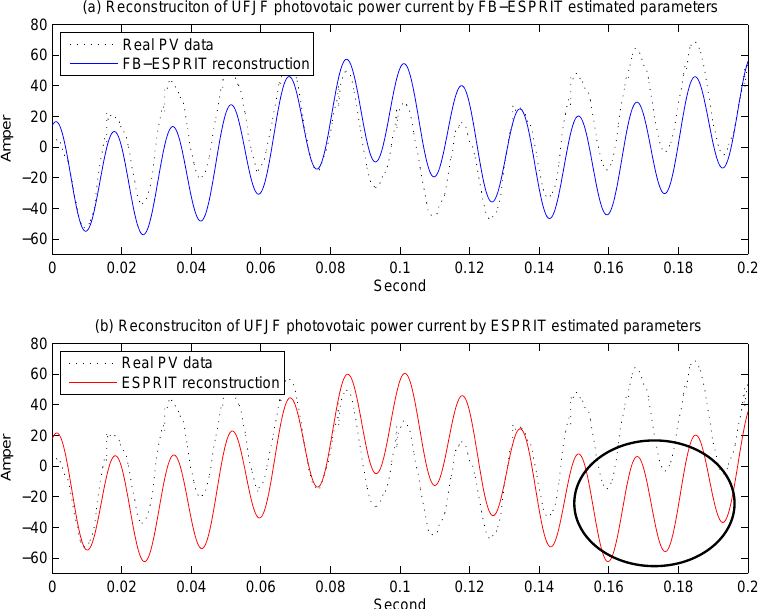
Figure 18. Original power signal (dashed-black) and the reconstructed signals using the parameters estimated by ( a ) FB-ESPRIT (solid-blue) and ( b ) ESPRIT